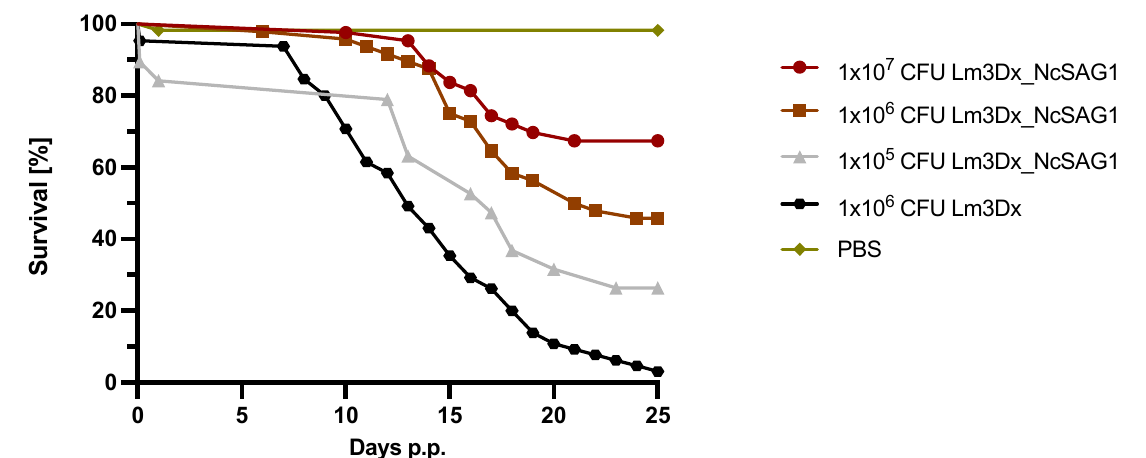
Figure 2. Efficacy assessment of the mutant vaccine strain Lm3Dx_NcSAG1 at different doses in a pregnant neosporosis